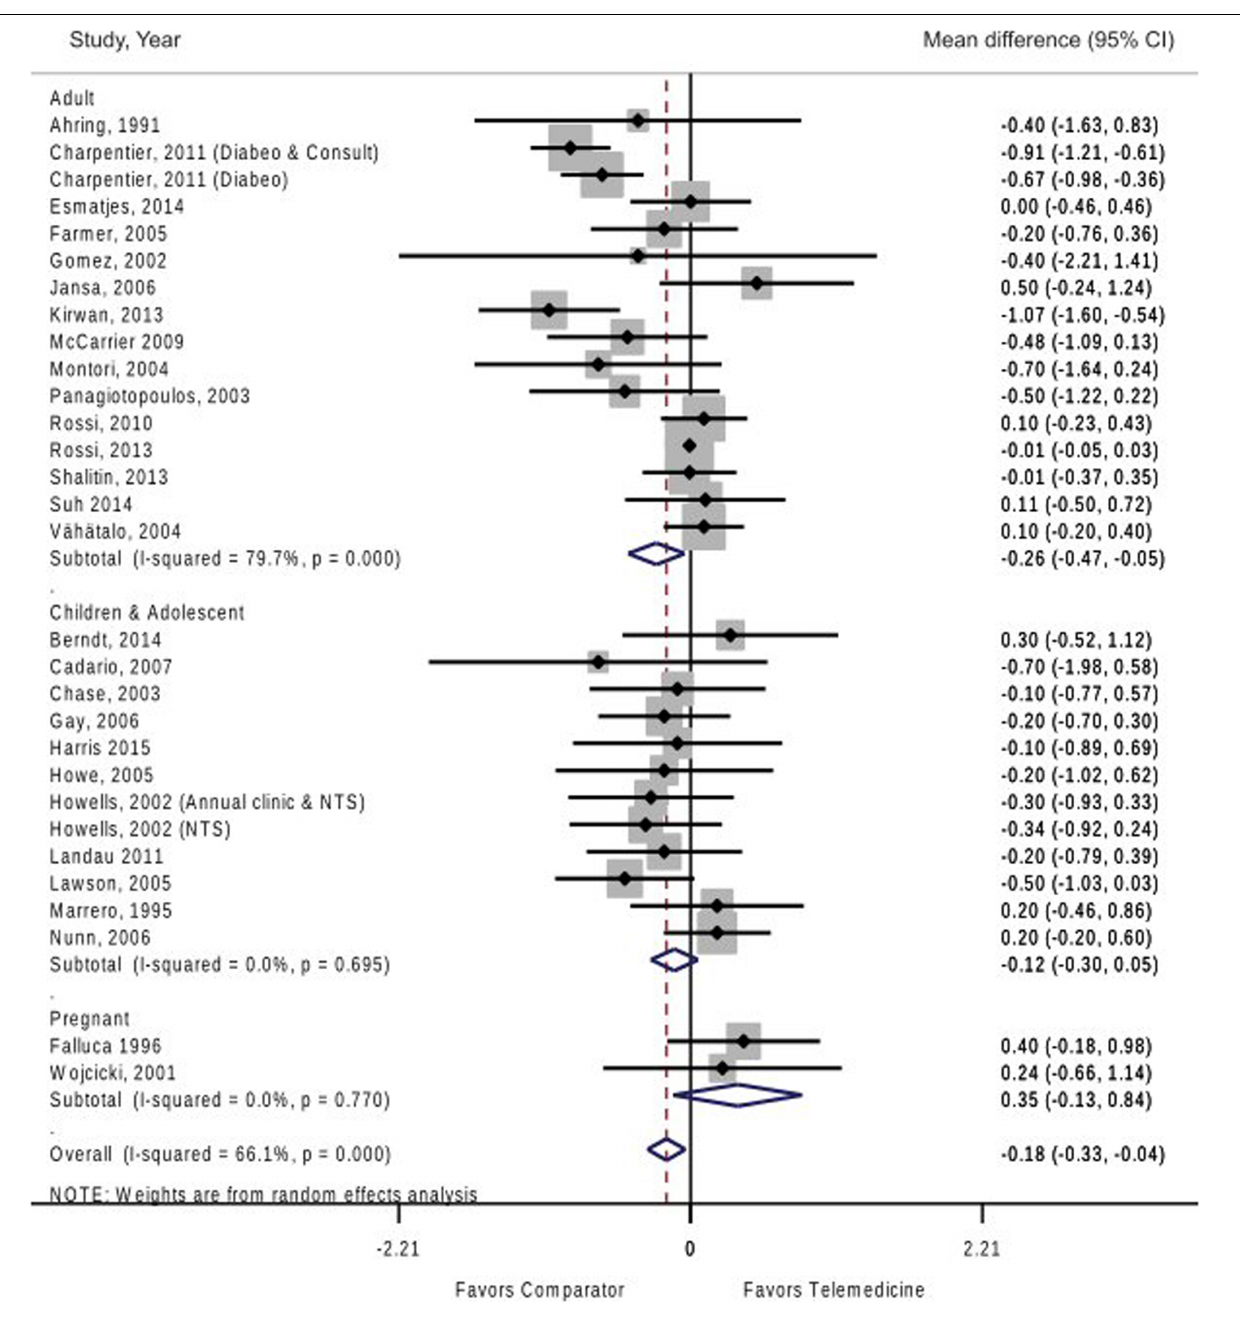
FIGURE 1 | Effect of telemedicine versus comparator on hemoglobin A1c at end of